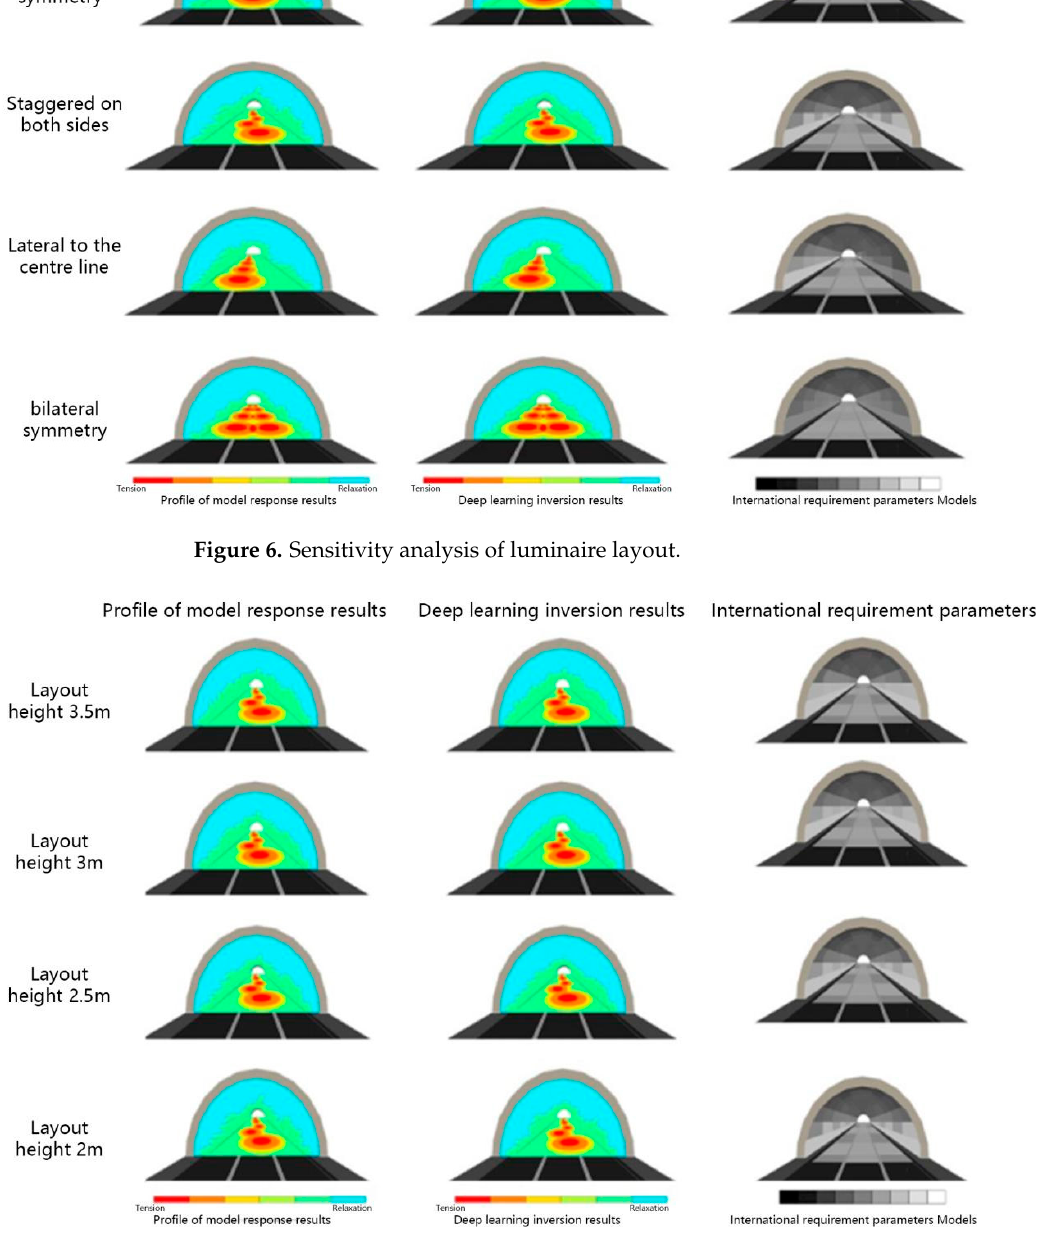
Figure 7. Sidewall reflective paint placement height sensitivity analysis.